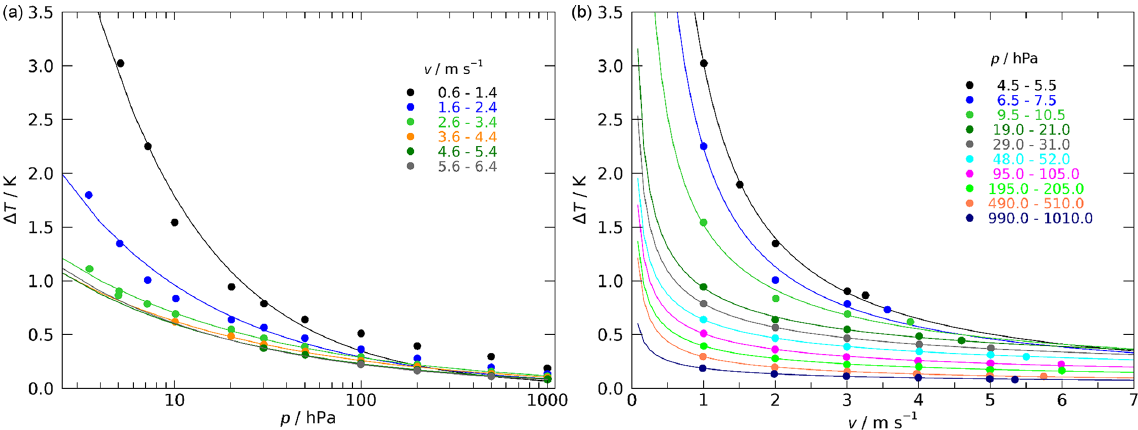
Figure 12. Example of measurement results (symbols), for a setting with an irradiation of 1024Wm − 2 , an incidence angle of 59 ◦ , and continuous sonde rotation with a period of T R = 16s. (a) (cid:49)T vs. p ; v as parameter. (b) (cid:49)T vs. v ; p as parameter. Pressure is given on a logarithmic scale for better visibility. The solid curves represent fits to the data using y = a · x − b ; the values of b are between 0.30 and 0.65.